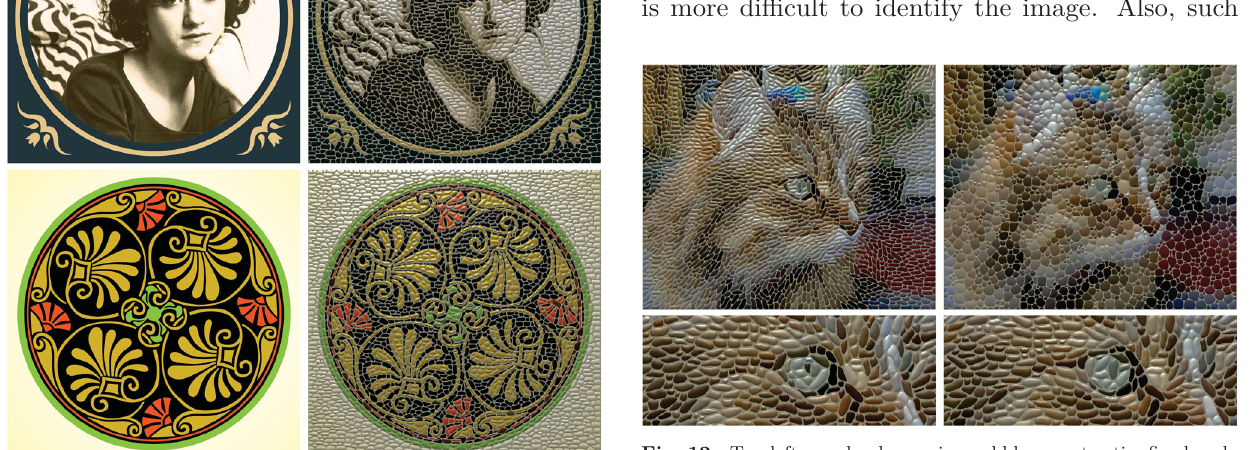
Fig. 12 Top left: randomly varying pebble aspect ratio, fixed scale. Top right: randomly varying pebble scale, fixed aspect ratio. Bottom: rendering is nondeterministic due to random scale